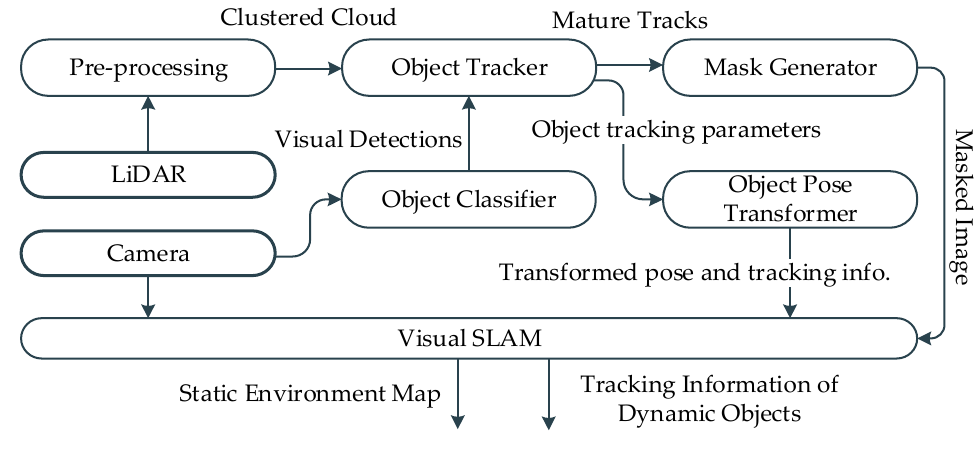
Figure 1. Framework for joint MODT and